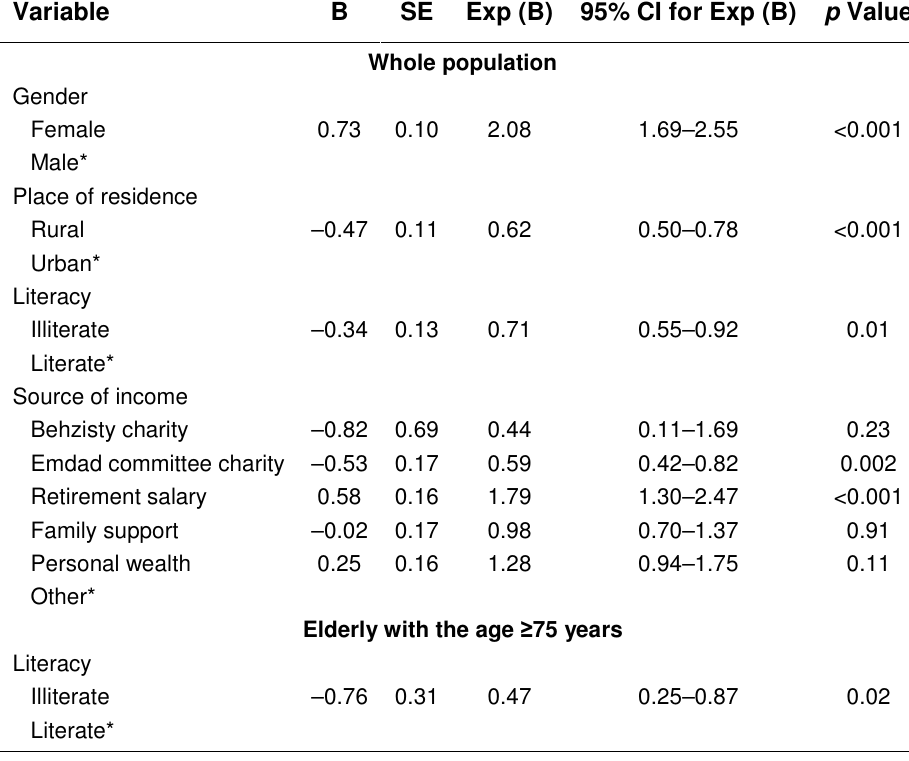
The Relationship between BMI and Some Socioeconomic Factors in the